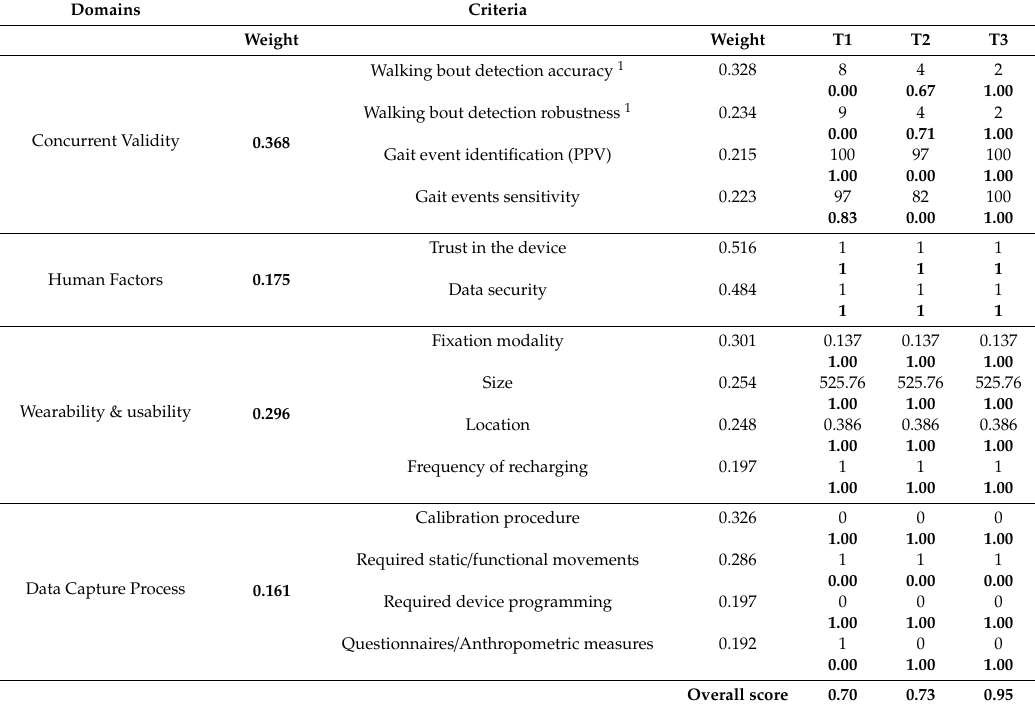
Table 3. Evaluation matrix applied to three concurrent methods. Normalised scores are reported in